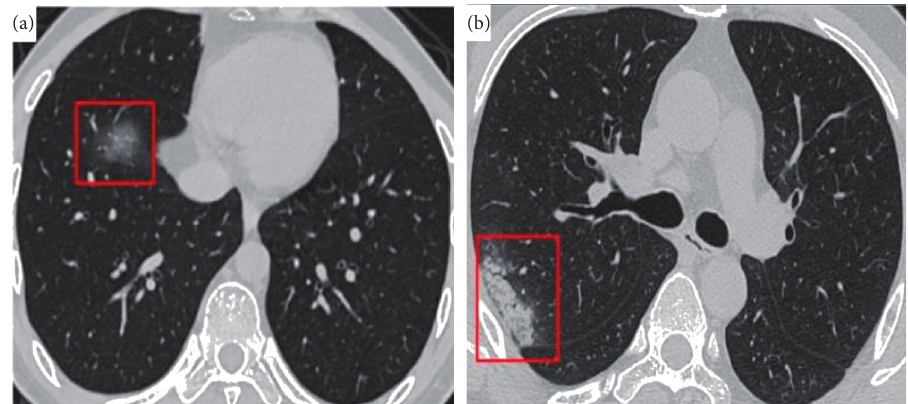
Figure 2: (a) Chest CTscan image shows a pure ground-glass opacity (GGO) in the right lower lobe (red frame). (b) Consolidation in the right lobe subpleural area (red